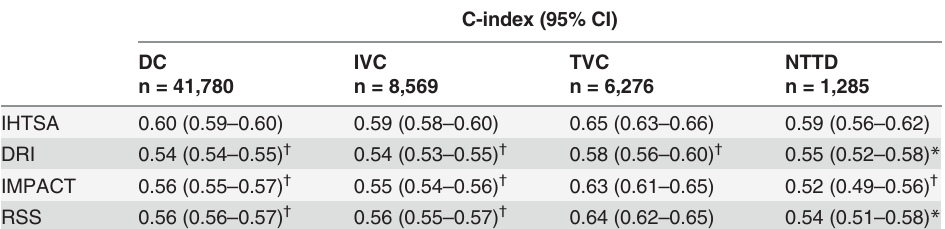
p (cid:1) 0.001 compared with ITHSA. CI, con fi dence interval; DC, derivation cohort; DRI, donor risk index for transplantation (reported in the paper by Weiss et al. [6]); IMPACT, index for mortality prediction after cardiac transplantation (reported in the paper by Weiss et al. [7]); ITHSA, international heart transplantation survival algorithm; IVC, internal validation cohort; NTTD, Nordic thoracic transplantation database; RSS, risk-strati fi cation score (reported in the paper by Hong et al. [9]); TVC, temporal validation cohort.